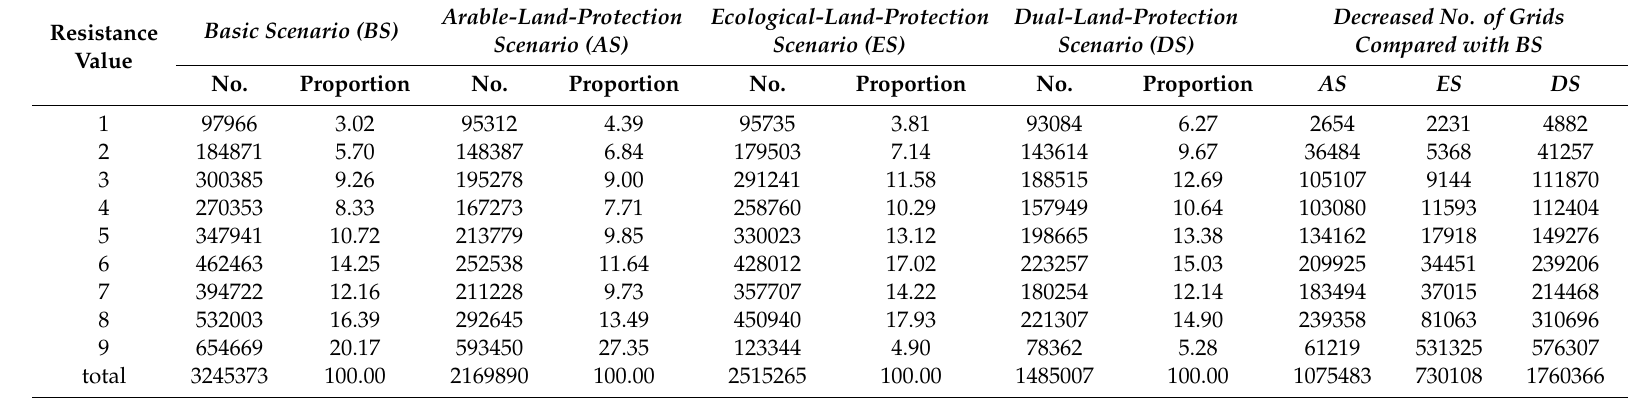
Table 3. Distribution of grids’ resistance value under four